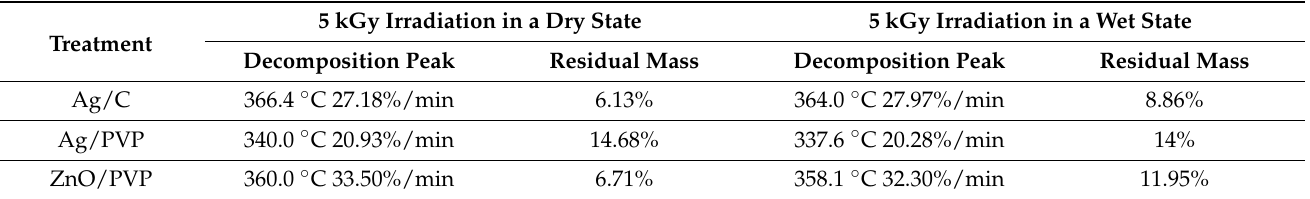
Table 2. Comparative TGA data, treated by NP impregnation and irradiation cotton samples.